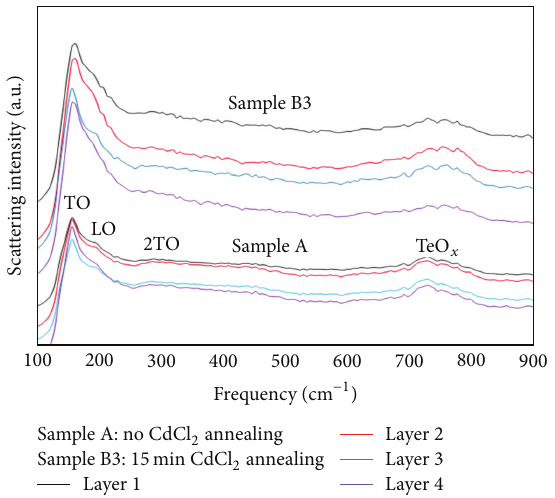
Figure 4: 𝐽 - 𝑉 curves for the best performing cells from the two samples made without (A) and with (B3) CdCl 2